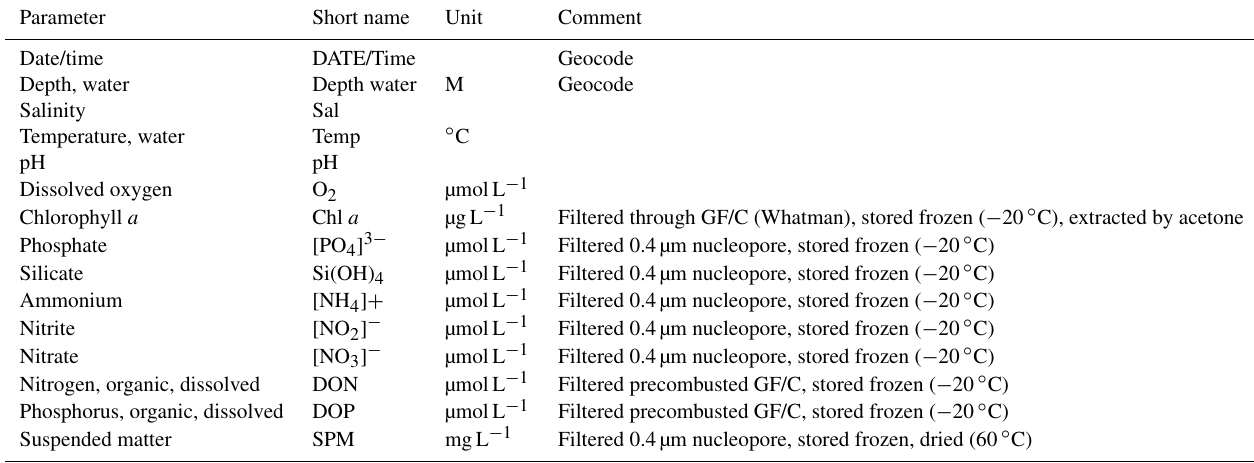
Figure 1. Map of the German Bight, with the sampling area (Sylt–Rømø bight) enlarged with the main sampling stations of the Sylt Roads LTER time series and their geographical position. LL is Lister Ley or Lister Reede, KH is the entrance of Königshafen, FT is the LL ferry terminal, and L2 and L3 are the Lister 2 and 3 stations sampled in the early part (until 1991) of the time series only. Table 1. Compilation of the physical and hydrochemical parameters at the Sylt Roads observatory (short name, units, and information on sample